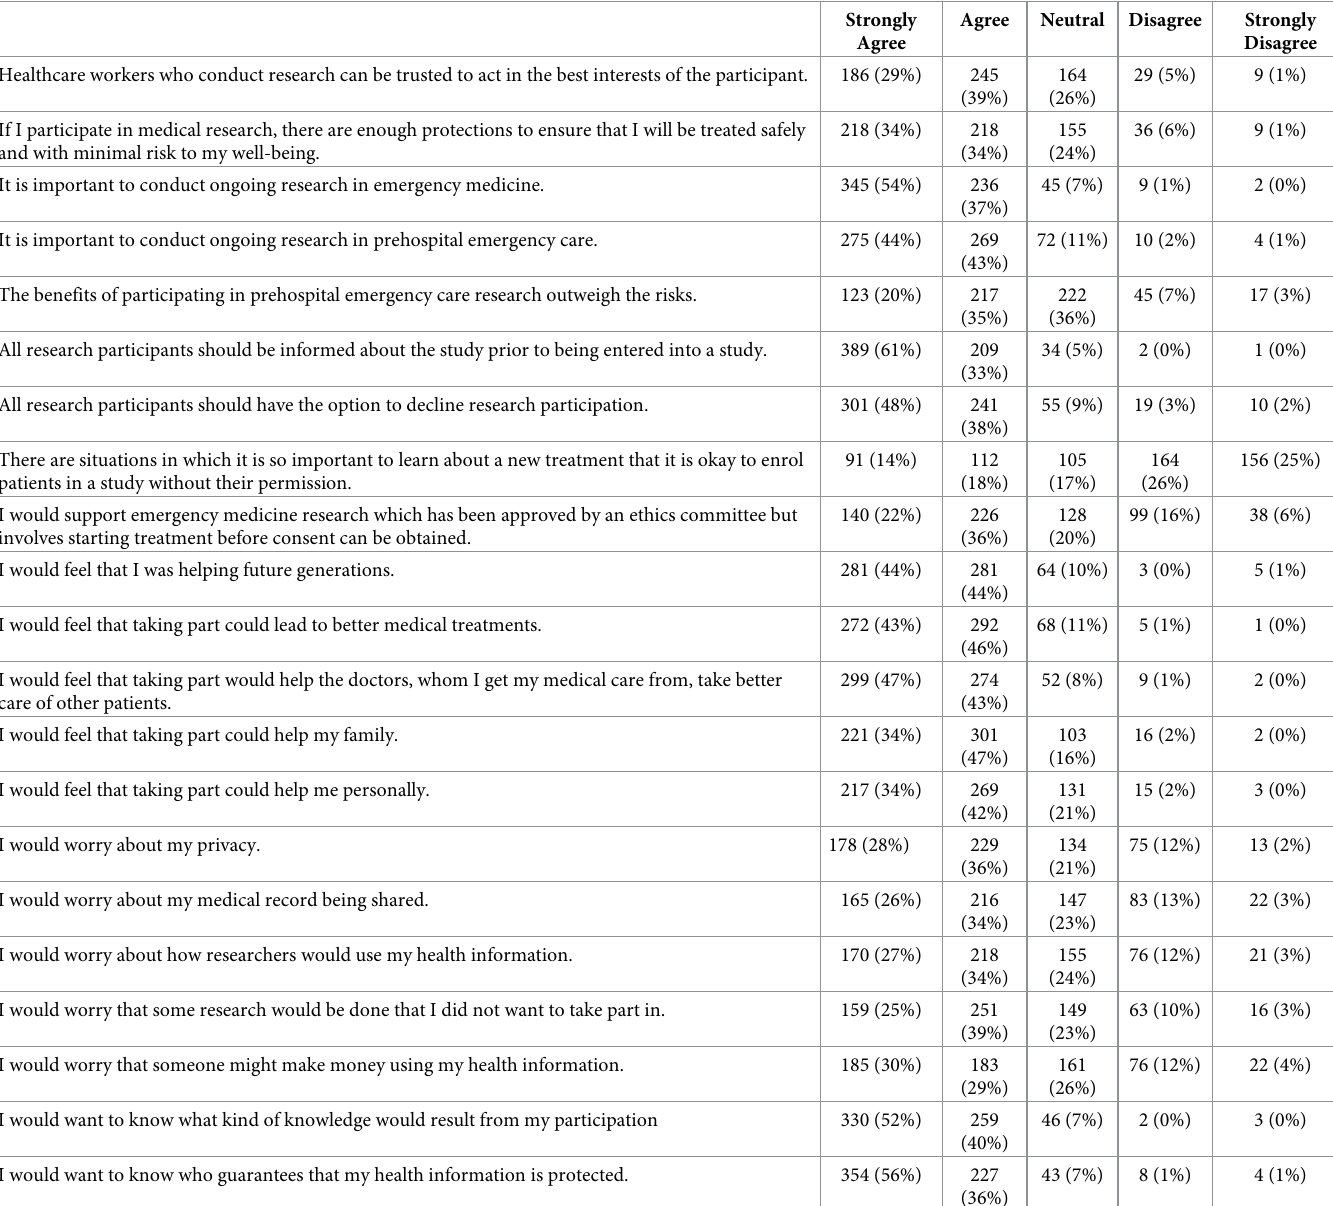
Table 2. Views on emergency care research.